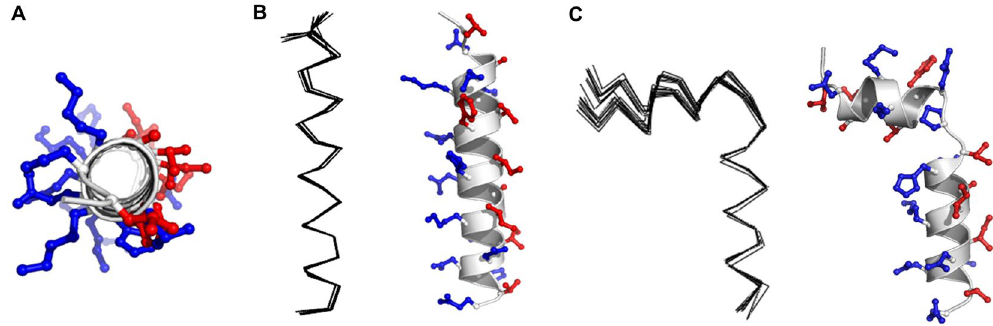
Figure 1. ( A ) Head-on view of the amphipathic N-terminal helix from Leu 2 to Gln 24 of Ps. The superpositions of the 20 lowest energy structures were calculated from the NMR data and ribbon diagram of the lowest energy structure for ( B ) Ps and ( C ) Ps-P in 200 mM DPC micelles. The hydrophobic residues are indicated in red, and the hydrophilic residues are shown in